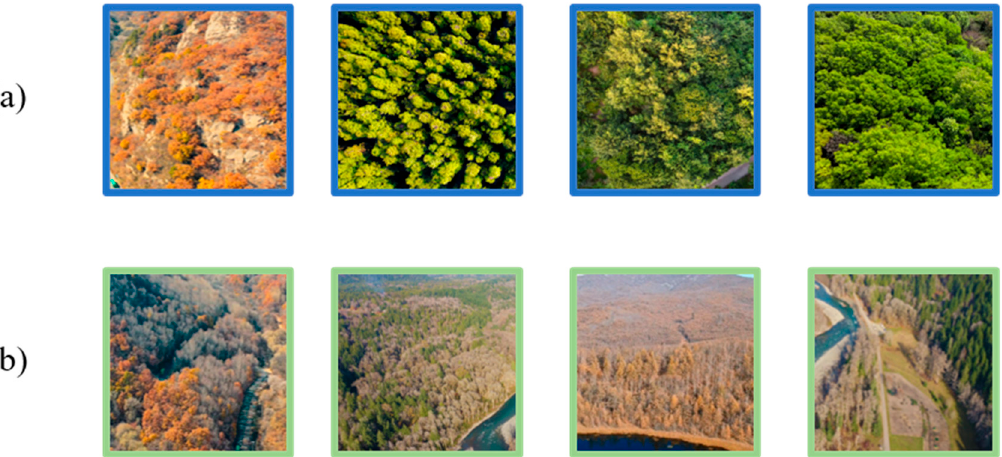
Figure 3. Example images from the aerial dead tree clusters dataset: ( a ) images without dead and old trees: ( b ) images including dead and old trees.